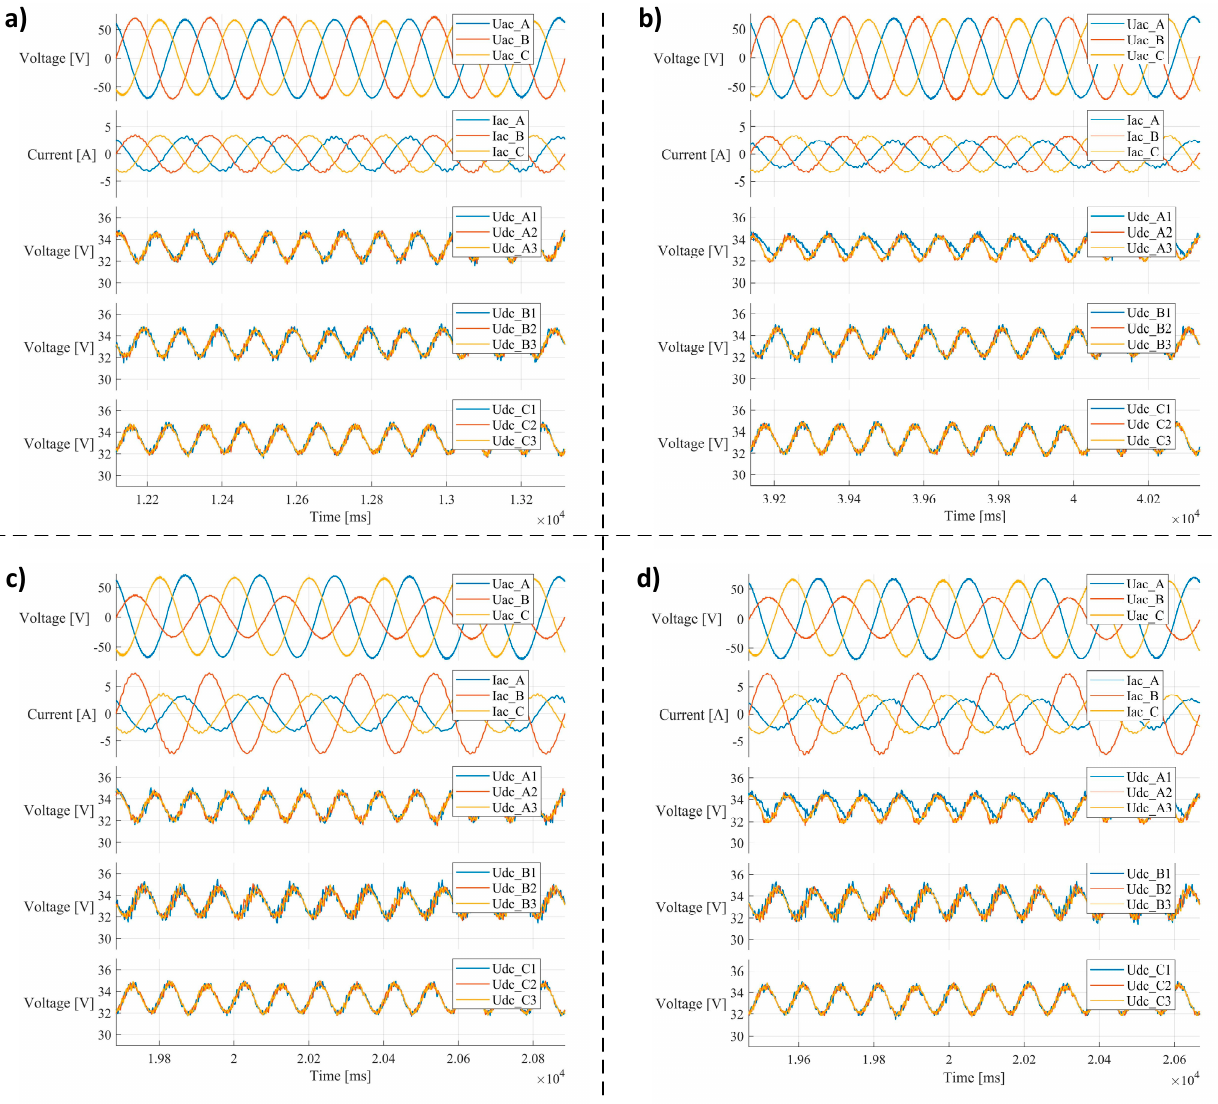
Figure 15. Steady-state operation under: ( a , b ) symmetrical grid voltages, ( c , d ) unbalanced grid voltages, ( a , c ) equal SM loads, ( b , d ) non equal SM loads. From the top: grid line voltages u AC , x , grid line currents i AC , x , DC voltages U DC , xk .